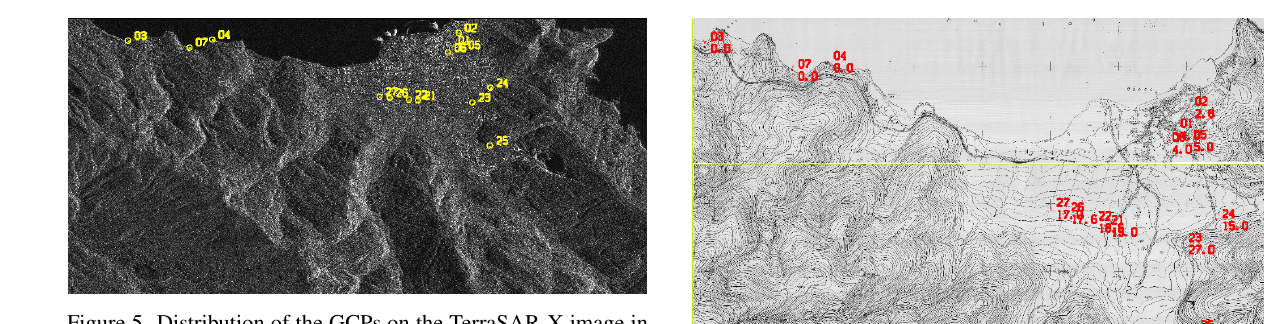
Figure 5. Distribution of the GCPs on the TerraSAR-X image in Thassos.